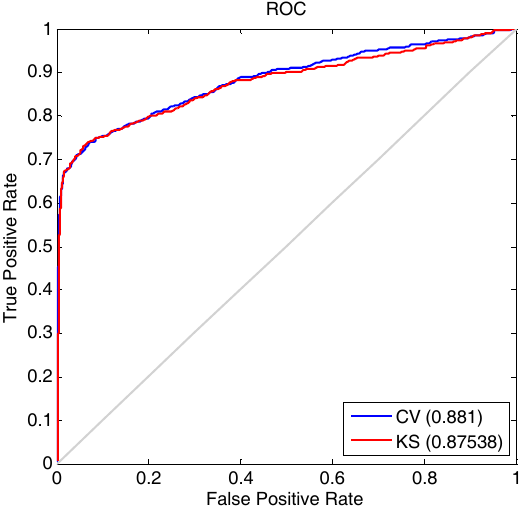
Figure 8. The ROC curve for results calculated using the proposed method and KS statistic as metric.